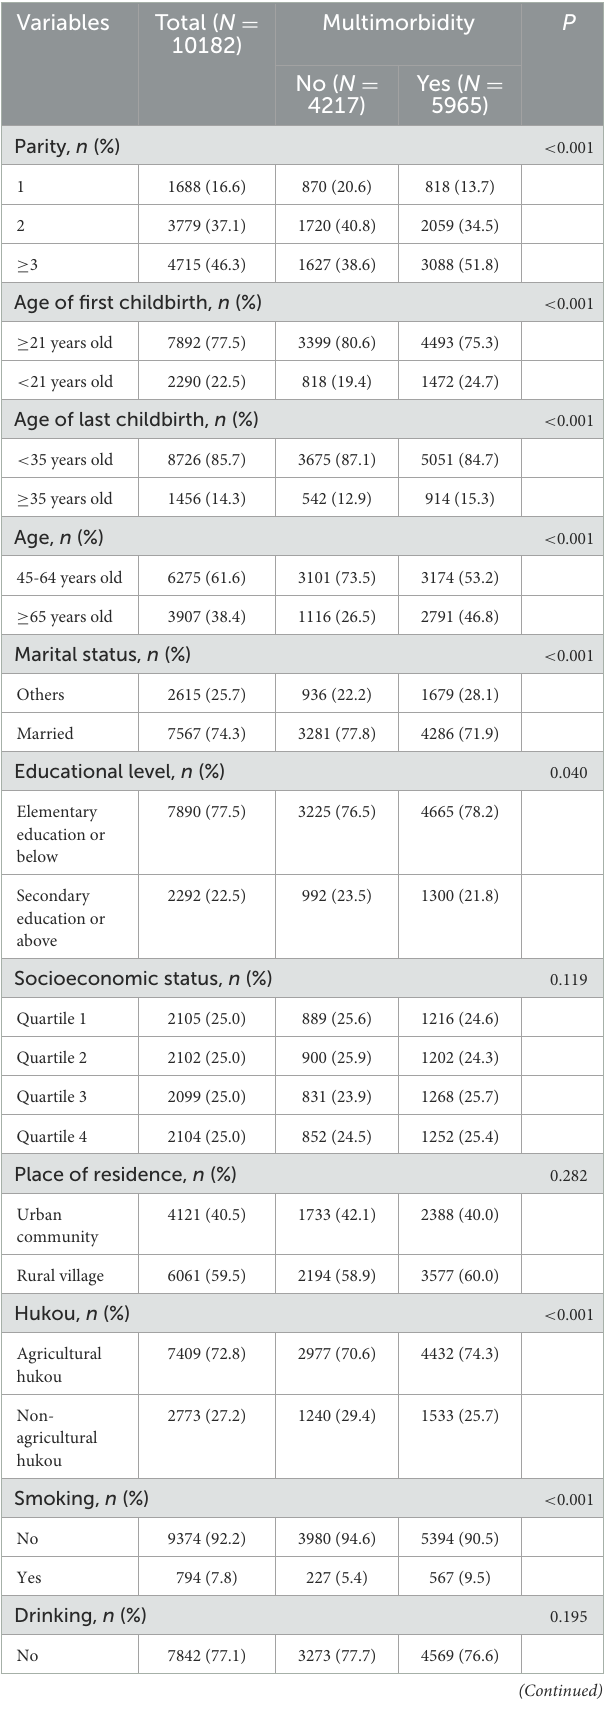
TABLE 1 Descriptive characteristics of participants in this